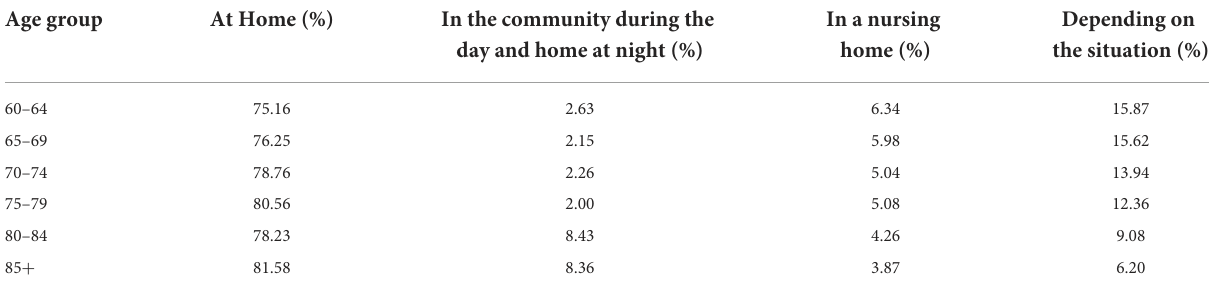
TABLE 8 Willingness of elderly people in the Yangtze River Delta region to age in a residential care facility.